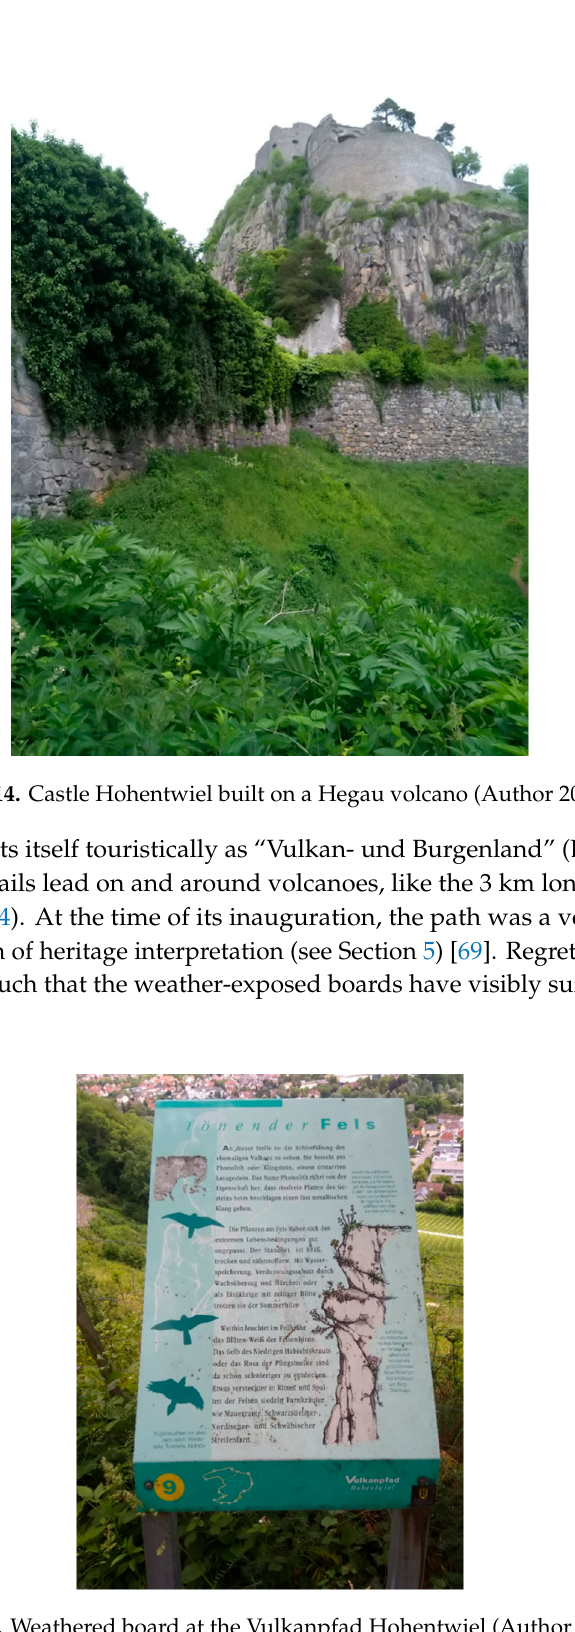
Figure 15. Weathered board at the Vulkanpfad Hohentwiel (Author 2020).